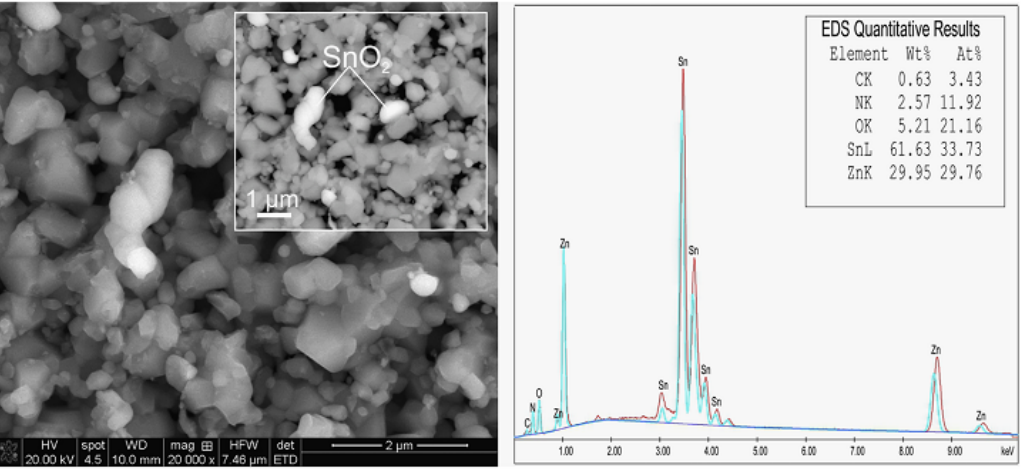
Figure 14. SEM/EDX analysis of the 50% SnO 2 -50% ZnO sensitive pellet, from ref.